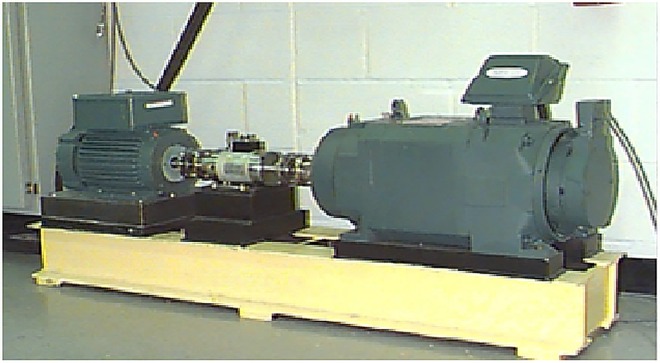
Experimental rig